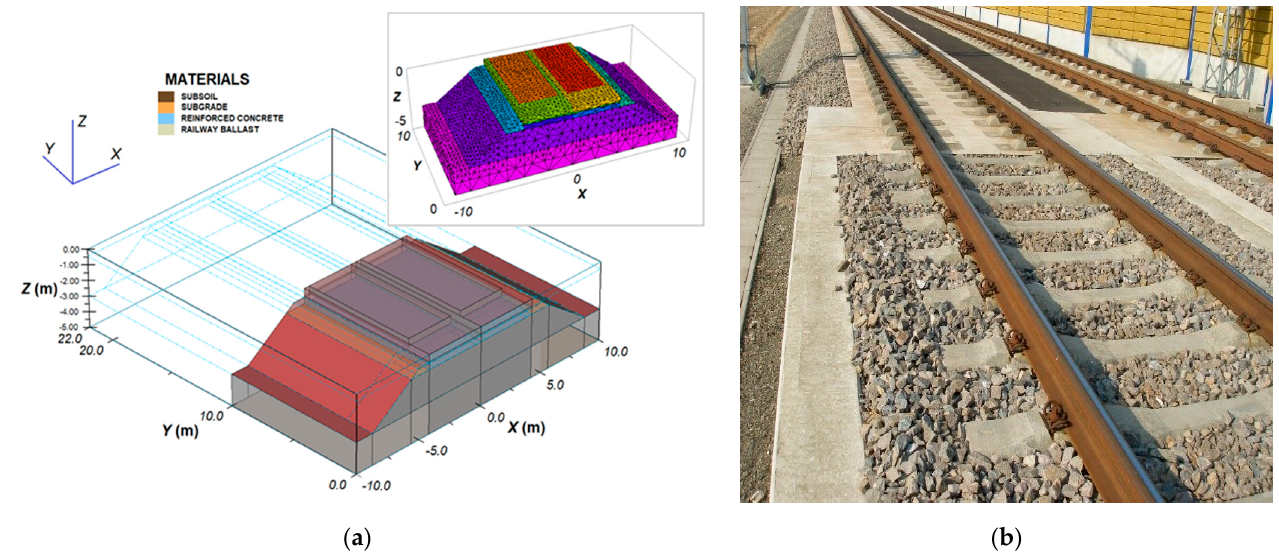
Figure 2. Transition zone near the tunnel Turecky Vrch in Trencianske Bohuslavice: ballasted and fixed track with linear reinforced concrete tub, V = 160 km/h: ( a ) Numerical design—structural elements [6,14]; ( b ) Photo: Reinforced concrete tub with ballast on railway main corridor [Hodas].